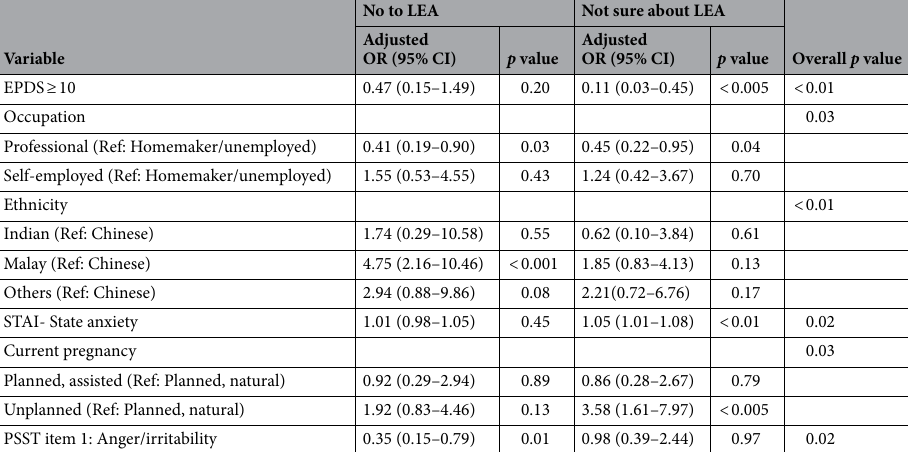
Table 4. Multivariable logistics regression for LEA preference. Adjusted ORs were obtained from multivariable logistic regression by taking potential confounders ( p < 0.20) identified by univariate analysis. The reference group is “yes to LEA”. CI confidence interval, EPDS Edinburgh postnatal depression scale, LEA labor epidural analgesia, OR odds ratio, PSST premenstrual symptoms screening tool, STAI state-trait anxiety